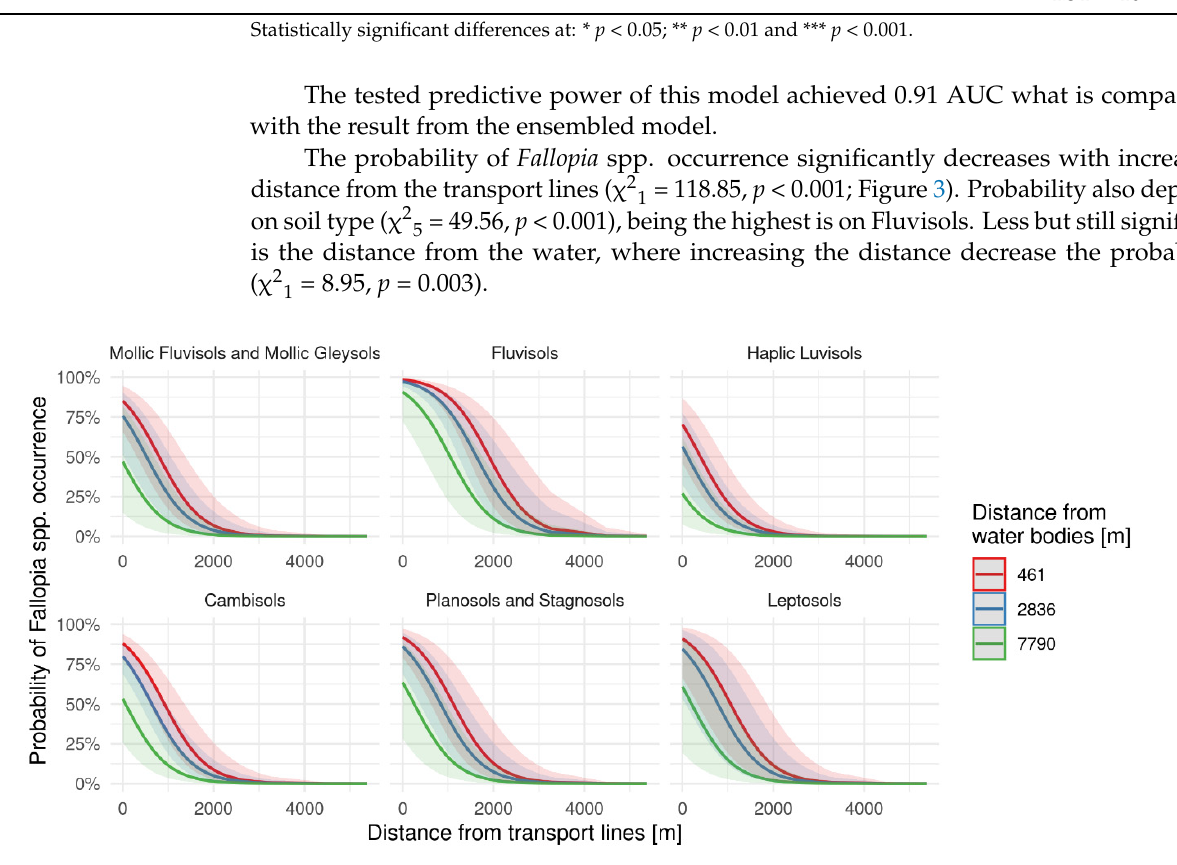
Figure 3. Modelled probability of Fallopia spp. based on distance from transport lines, water bodies and different soil types. Water bodies distances represent 10% (red), 50% (blue) and 90% (green) percentile.